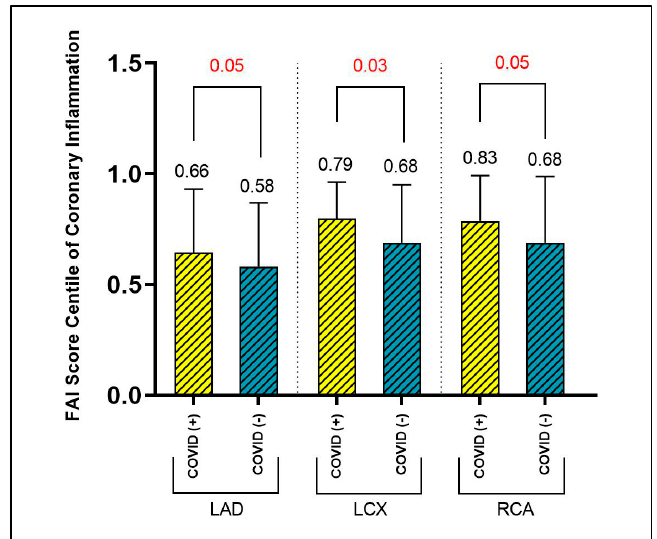
Figure 3. PVAT-FAI Score Centile of Coronary Inflammation for each coronary artery.